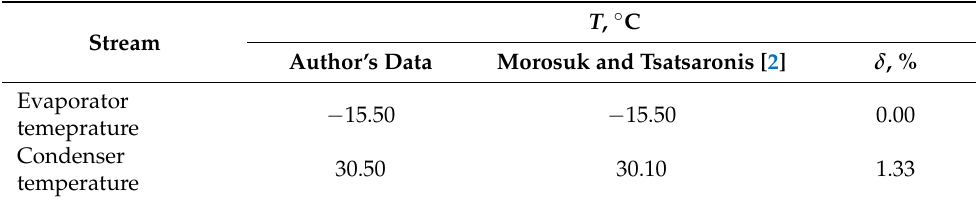
Table 5. Temperatures of evaporation and condensation for the refrigeration cycle with unavoidable exergy